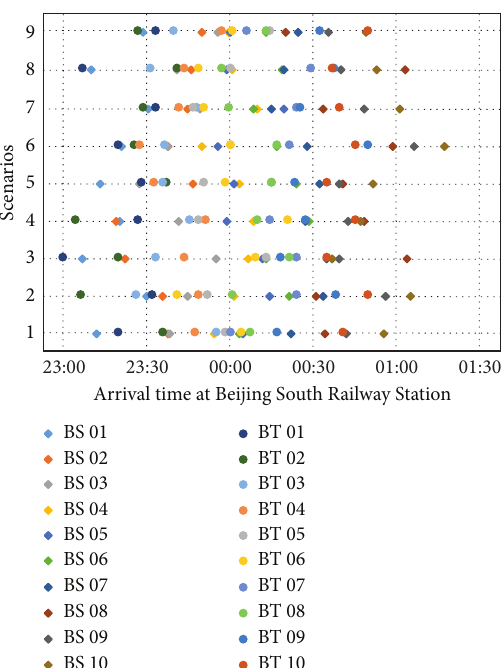
Figure 7: Arrival time of HSR trains at BSRS under each